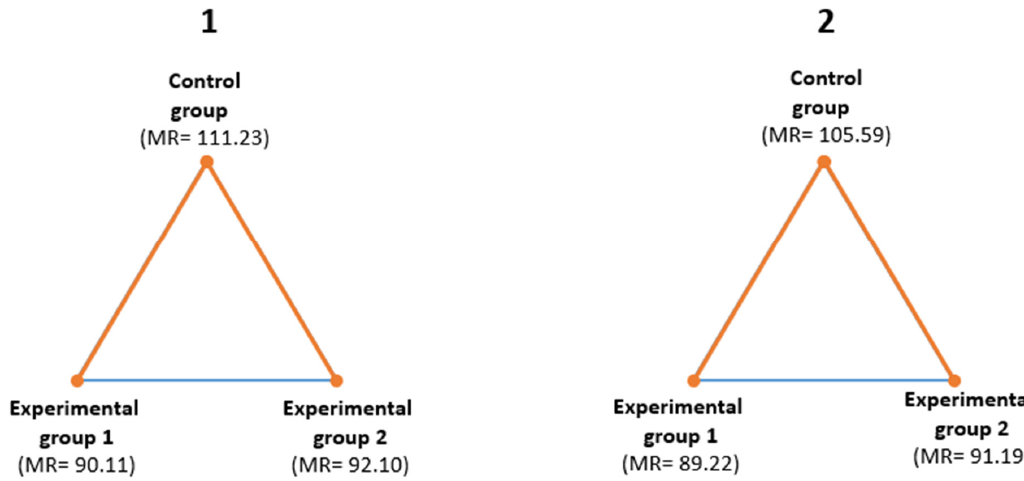
Figure 3. Mann–Whitney U test for the activation dimension (1) and the absence of a negative effect dimension (2). MR: Mean Ranks.